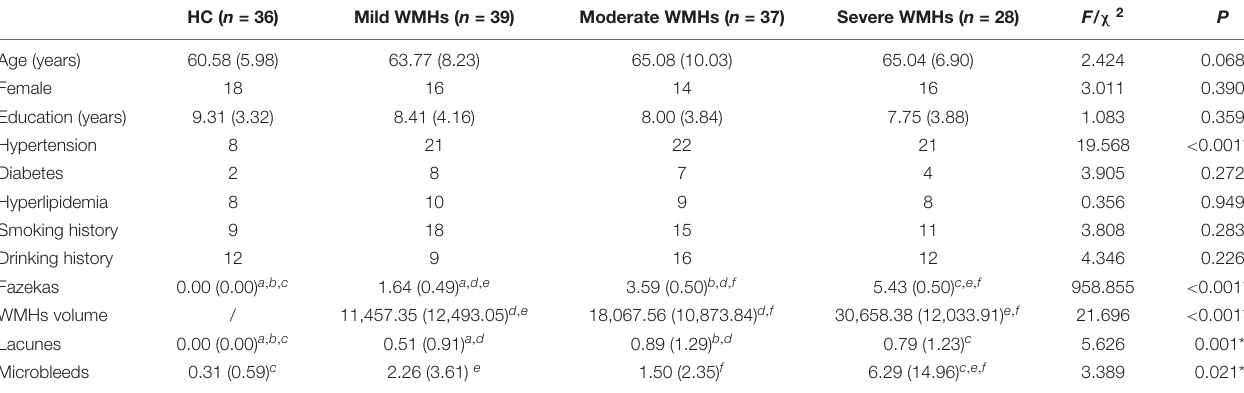
TABLE 1 | Demographic and cerebral small vessel disease neuroimaging manifestations of participants in the four groups [mean (SD)]. HC ( n = 36) Mild WMHs ( n = 39) Moderate WMHs ( n = 37) Severe WMHs ( n = 28) F / χ 2